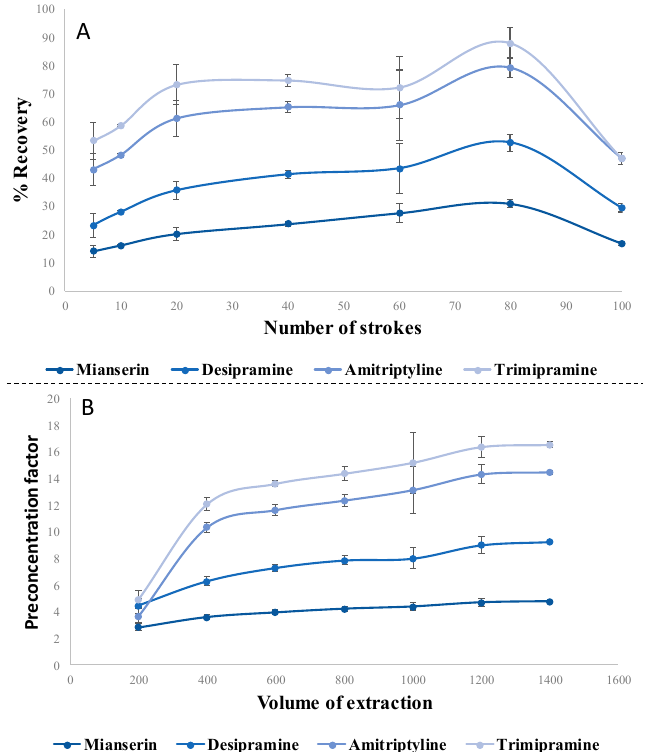
Figure 4. Effect of the ( A ) number of strokes and ( B ) sample volume on the extraction recovery of the analyte. The sample volume is defined as the volume of sample placed in the extraction vial. Each condition was evaluated in triplicate.